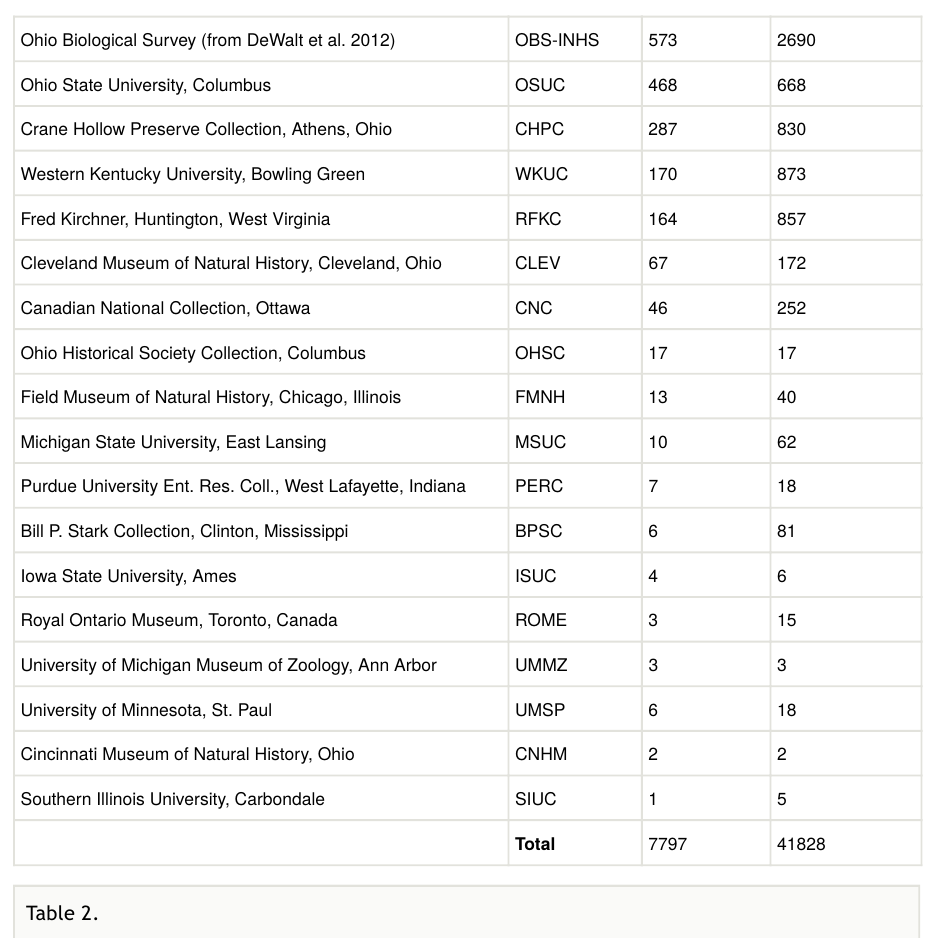
Stone fl y names associated with Ohio since Needham and Claassen (1925). See Suppl. material 1 for accounting of all 53 works to ever list stone fl ies for